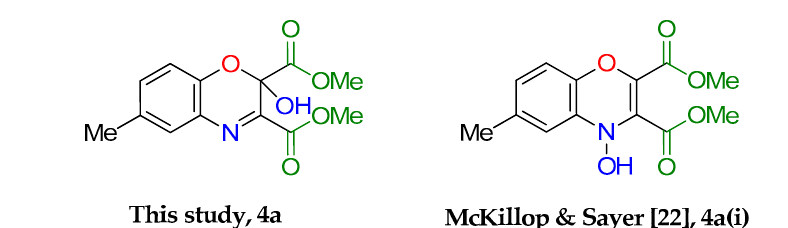
Figure 5. The assigned structure of 4a obtained in this study compared to the literature assigned structure for the same reaction.